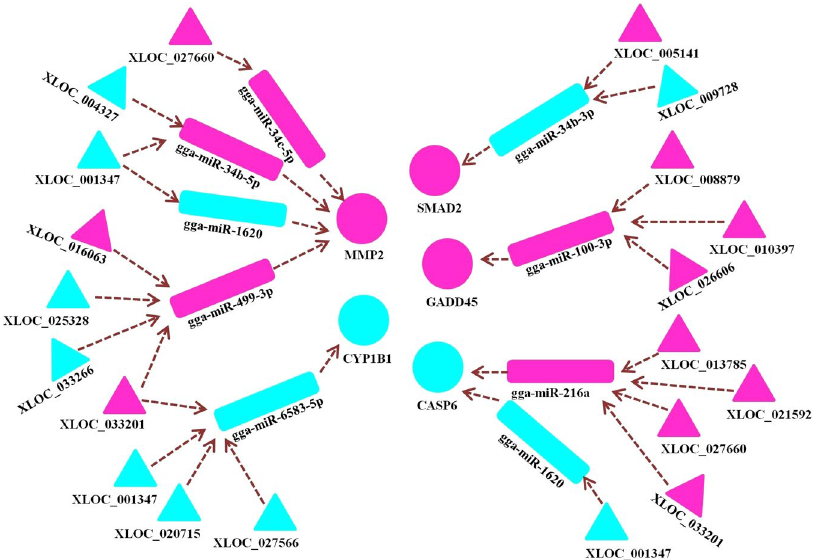
Figure 8. Predicted interaction between lncRNA transcripts and MMP2 , CYP1B1 , SMAD2 , GADD45 , and CASP6 genes. Aqua green and pink denote lower and higher expression levels in the atrophic ovary (AO),